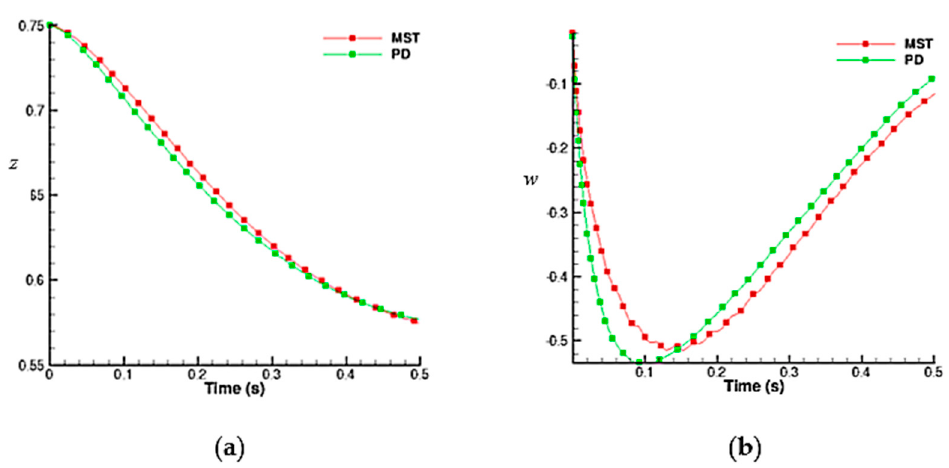
Figure 11. The z -components of the second particle position ( z ) and velocity ( w ) for the PD and MST methods are shown as functions of time. a = 0.1 and ε p = 0.7. The initial positions for the particles are (0.25, 0.25, 0.75) and (0.75, 0.25, 0.75). ( a ) z , ( b ) w . The dimensionless parameters are the same as in Figure 6.